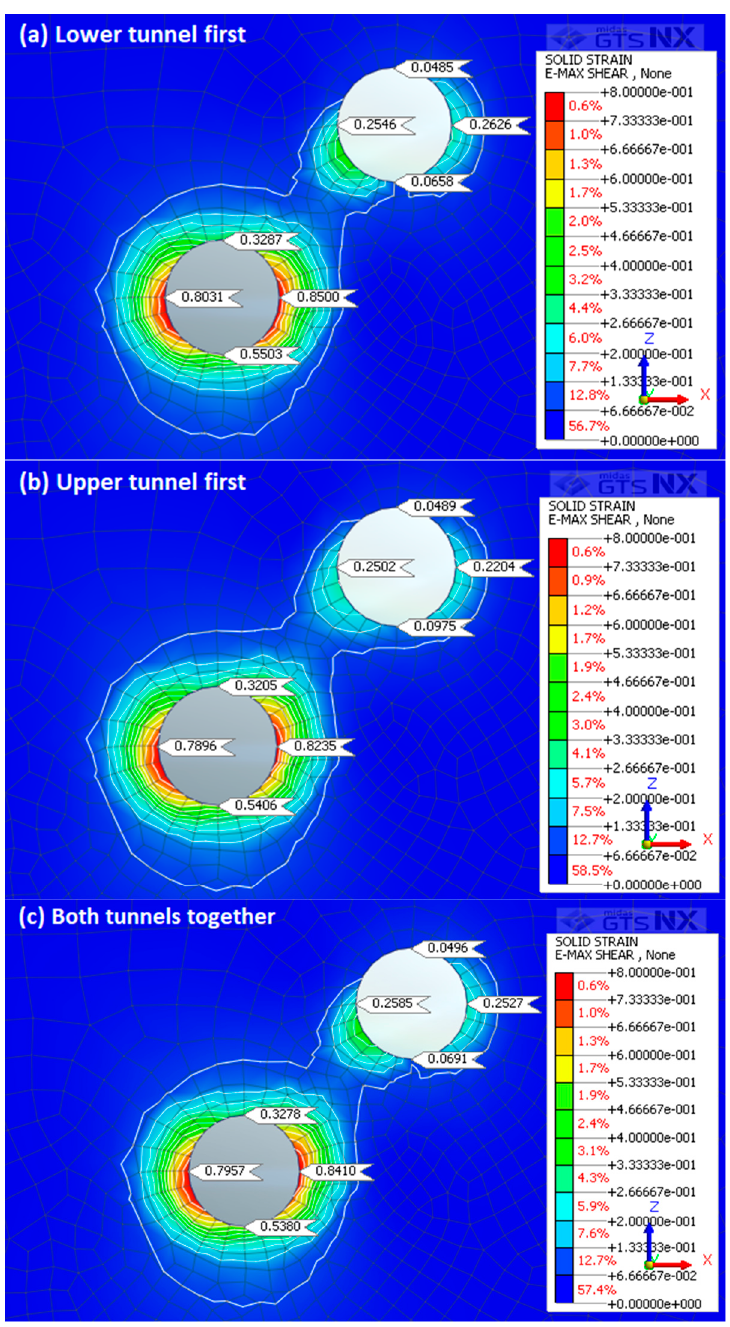
Figure 20. Effect of construction sequence on shear strain in the crown, invert, and springlines of twin tunnels at the end of excavation ( a – c